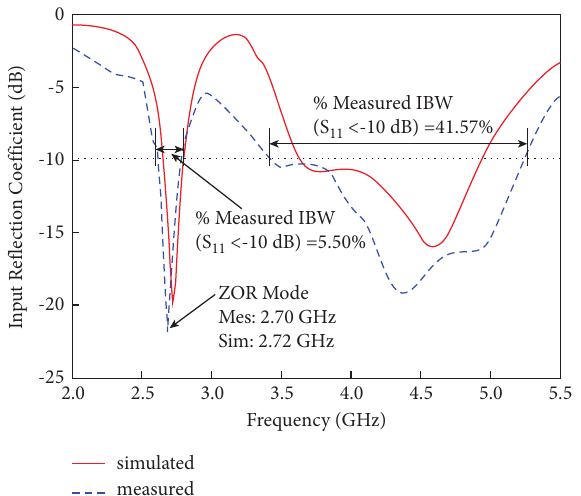
Figure 8: Simulated and measured input refection coefcients of the proposed dual-band MTM